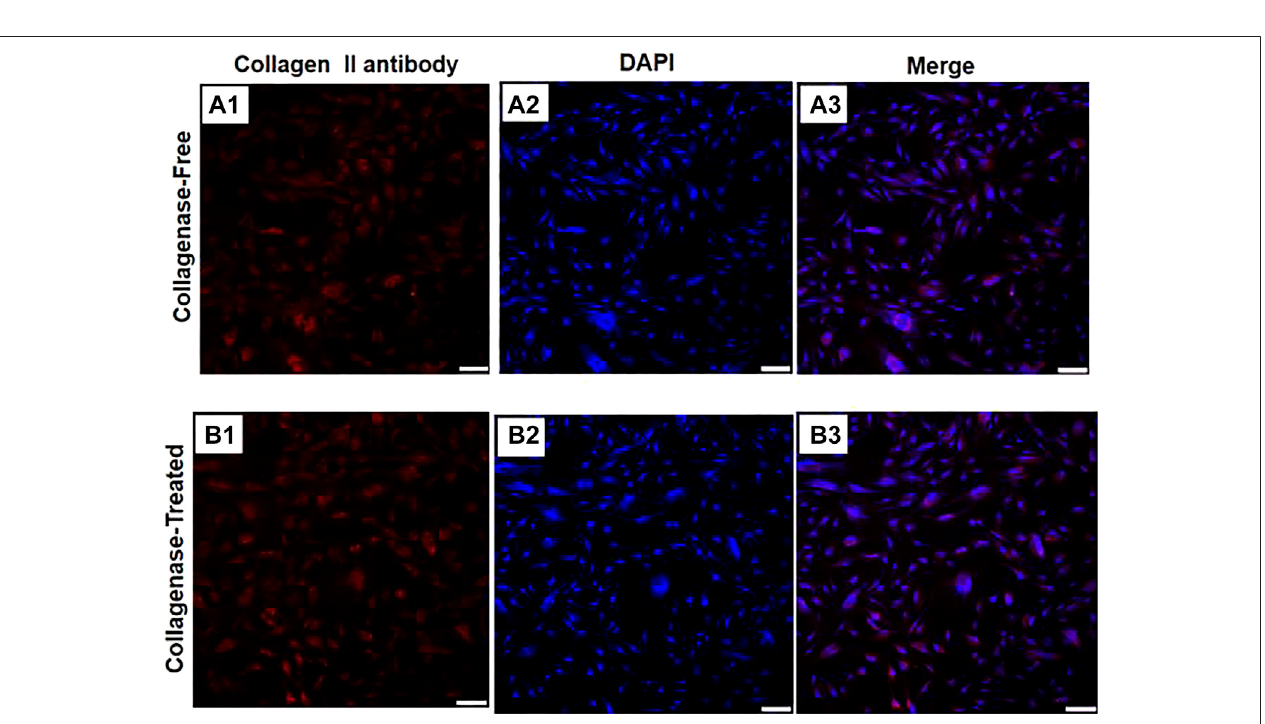
FIGURE 6 | Immuno fl uorescence diagrams of two IPFP-SCs obtained using the without enzyme method and digestion method after chondrogenic induction. A1 typeIIcollagenproducedbythecellmatrixafterchondrogenicinductionofIPFP-SCsusingthewithoutenzymemethodispositivelyexpressed;typeIIcollagenproduced by the cell matrix after chondrogenic induction of IPFP-SCs with B1 enzyme digestion was positively expressed, and all of them showed orange red color. A2 and B2 were nuclear images stained with DAPI, and the nuclei were blue. A3 and B3 were combined images of the corresponding cells. Scale bar = 100 μ m.